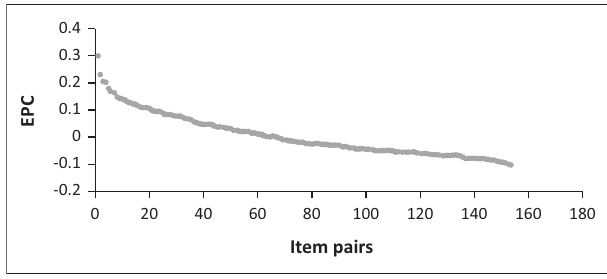
FIGURE 2: Ranked correlated residuals: One-factor model.